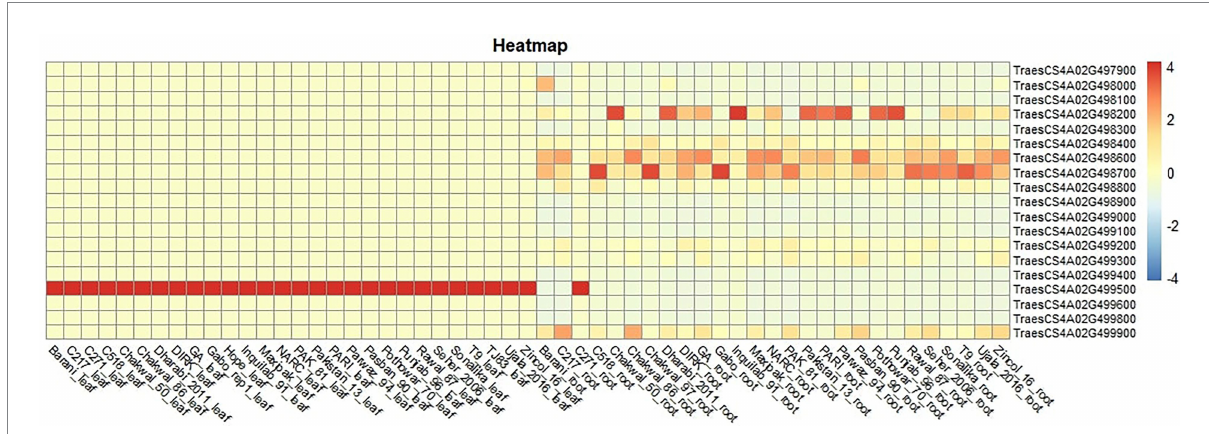
FIGURE 7 Expression of 19 genes in roots and leaves of a subset of 28 wheat cultivars used in this study.